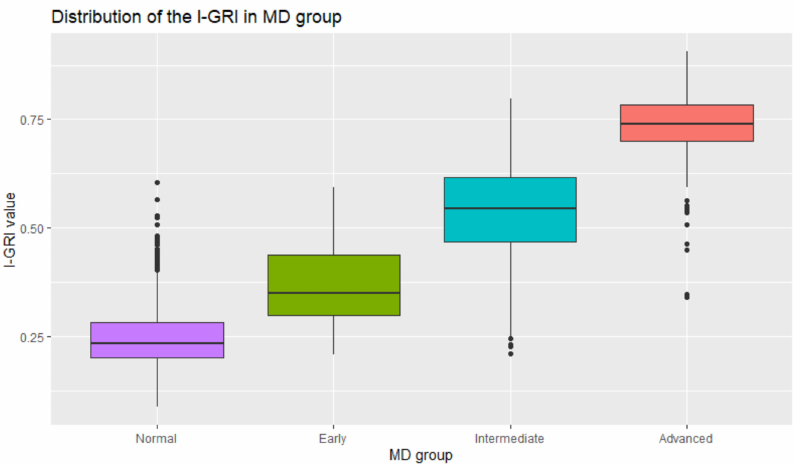
Figure 10. Distribution of the I-GRI values according to the MD groups.